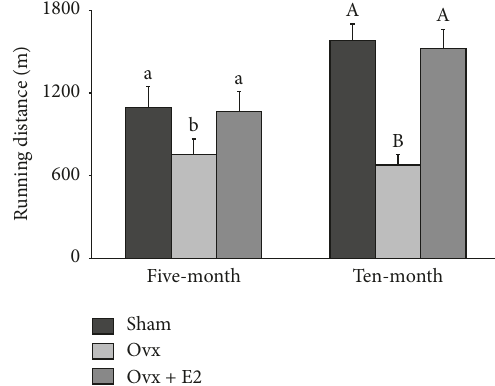
Figure 1: The effects of ovariectomy (ovx) and 17 𝛽 -estradiol (ovx + E 2 ) on 24-hour voluntary running distance in rats from the cohorts of initial ages of five months (A) and ten months (B). Values are means ± SEM. Bars that do not share the same superscript letters are significantly ( 𝑝 < 0.05 ) different from each other ( 𝑛 = 6 per treatment group). Voluntary running activity measured by activity wheel and distance counter in individual cages for 24 hours between one and two weeks before sacrifice was significantly decreased in older ovx rats (younger ovx rats tended to have a lower activity). E 2 administration prevented the lower activity